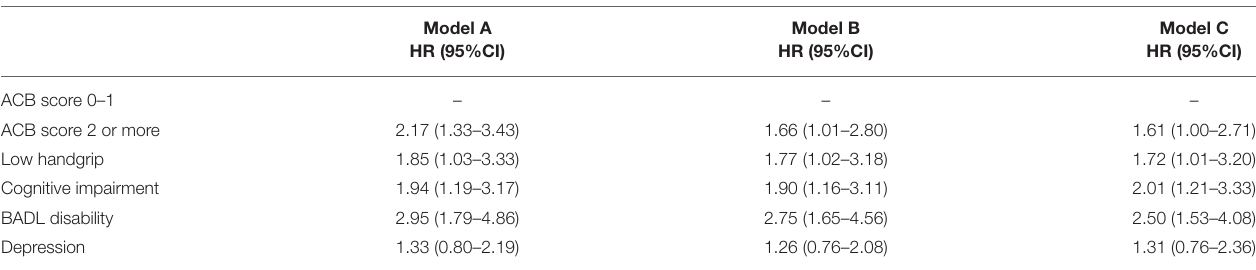
TABLE 2 | The Cox regression analysis of study risk factors in relation to 1-year